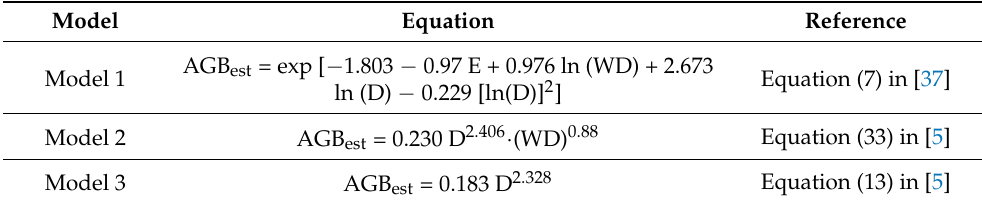
Table 1. Allometric equations used for AGB